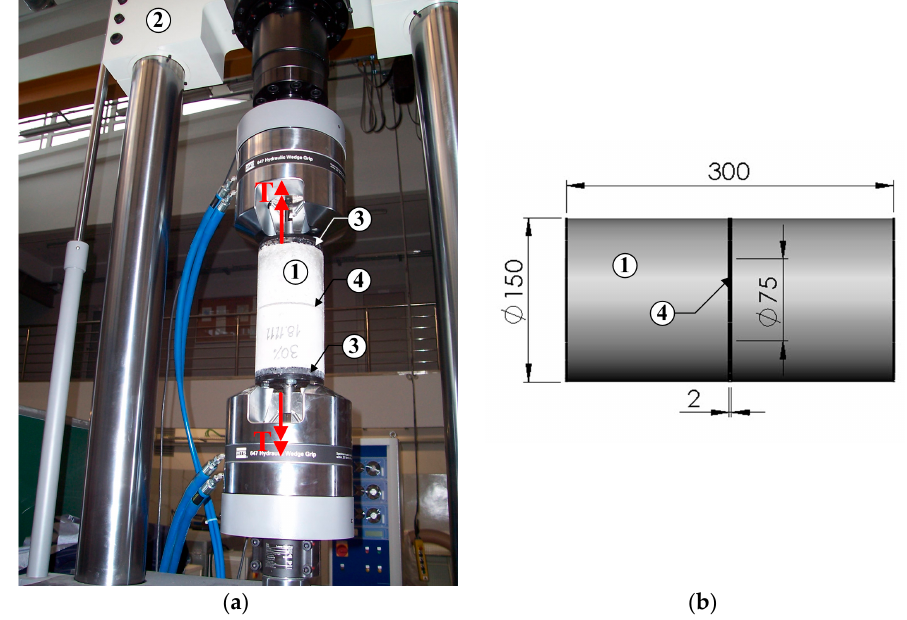
Figure 9. View of experimental stand for testing according to mode III fracture with loading conditions: ( a ) the device during testing, ( b ) specimen with dimensions; 1—specimen, 2—MTS 809 press, 3—steel elements, 4—initial crack, T —torque (dimensions in mm).